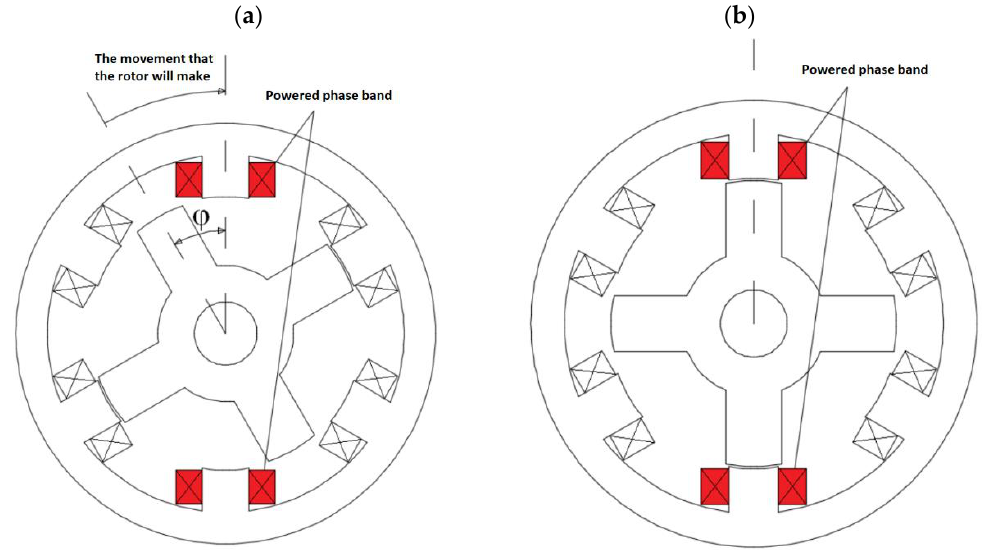
Figure 2. Movement of the rotor during SRM motor operation: ( a ) While energizing the phase band, the rotor will move by the angle φ aiming at the coaxial position; ( b ) rotor position after moving by the angle φ. the angle ϕ